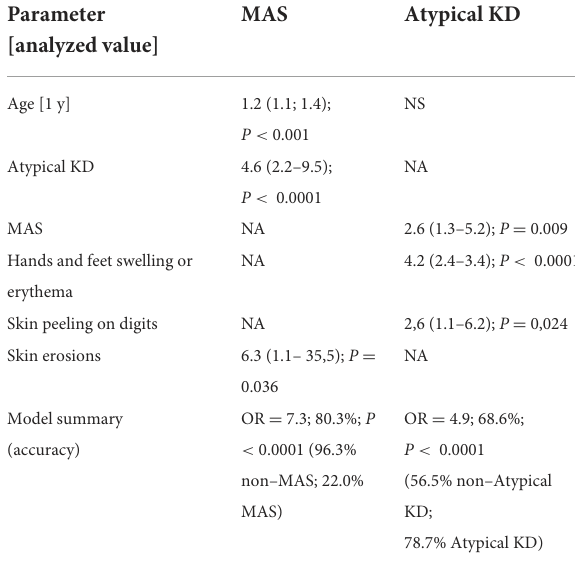
TABLE 1 Multivariate analysis of the association between symptom occurrence and the presence of macrophage activation syndrome (MAS) or atypical Kawasaki disease (KD) in 274 patients meeting MIS-C